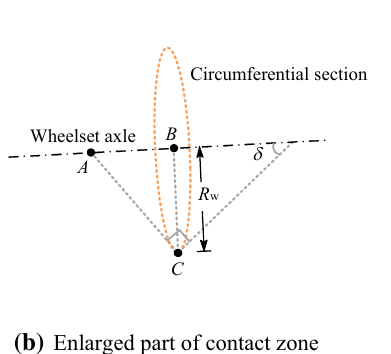
Fig. 3 Geometric relationship of